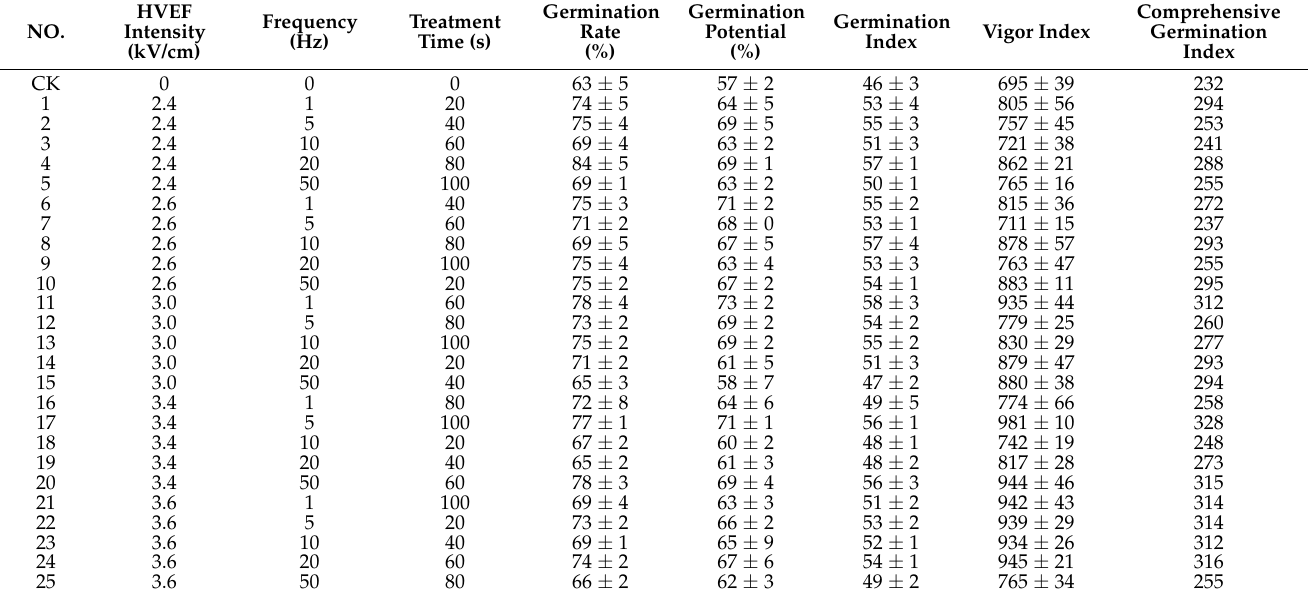
Table 2. Orthogonal germination experiment data of aged cotton seeds.